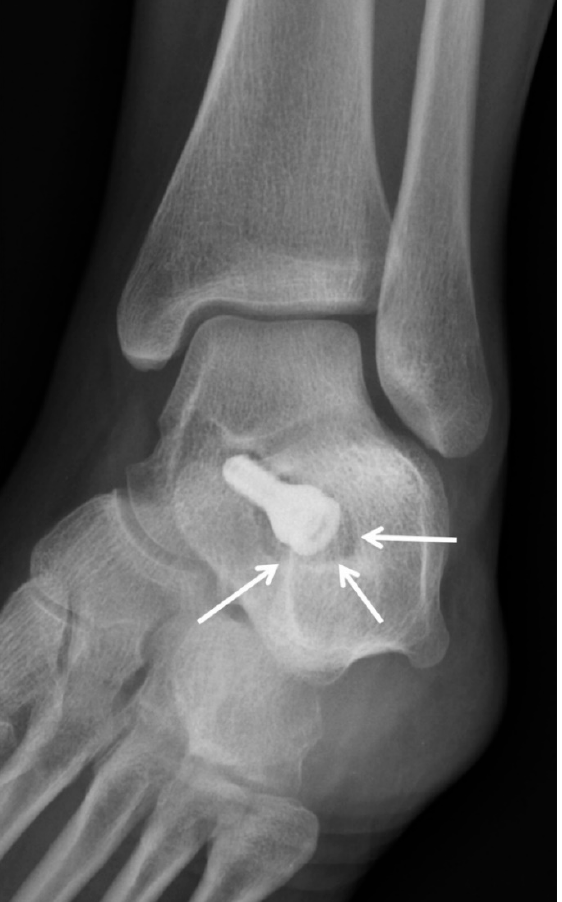
Figure 11. Prior history of subtalar arthroereisis placement. Mortise radiograph of the ankle demon- strates increased lucency surrounding the hardware concerning for loosening (white arrows).